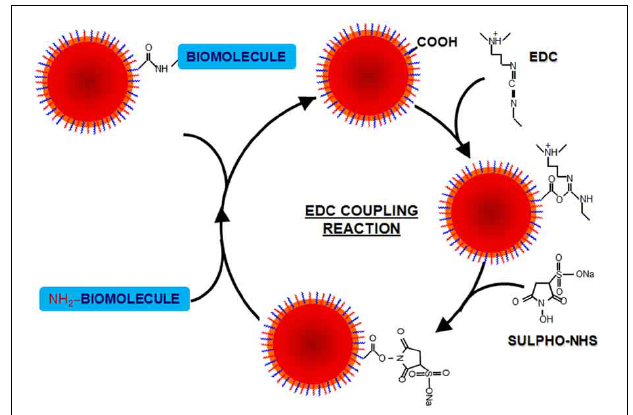
FIGURE 8 | EDC coupling reaction. The 1-ethyl-3-(3-dimethylaminopropyl)- carbodiimide (EDC) is a zero-length crosslinking agent used to couple carboxyl groups to primary amines. In the presence of N-hydroxysulfosuccinimide (Sulfo-NHS), EDC can be used to convert carboxyl groups to amine-reactive Sulfo-NHS esters. The addition of Sulfo-NHS stabilizes the amine-reactive intermediate by converting it to an amine-reactive Sulfo-NHS ester, thus increasing the efficiency of EDC-mediated coupling reactions. Excess reagent and crosslinking by products are easily removed by washing with water. Once EDC is water soluble, the crosslinking can be done under physiologic conditions without adding organic